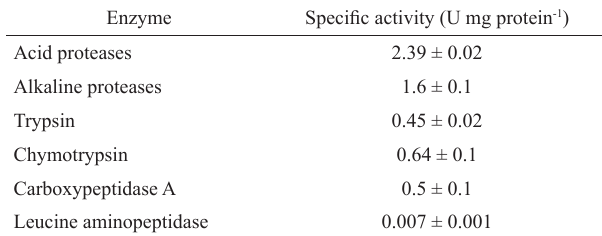
Tab. 1. Specific activity levels of digestive proteases (mean ± SD, n = 3) in enzymatic extracts of stomach and intestine from juveniles of Archosargus probatocephalus